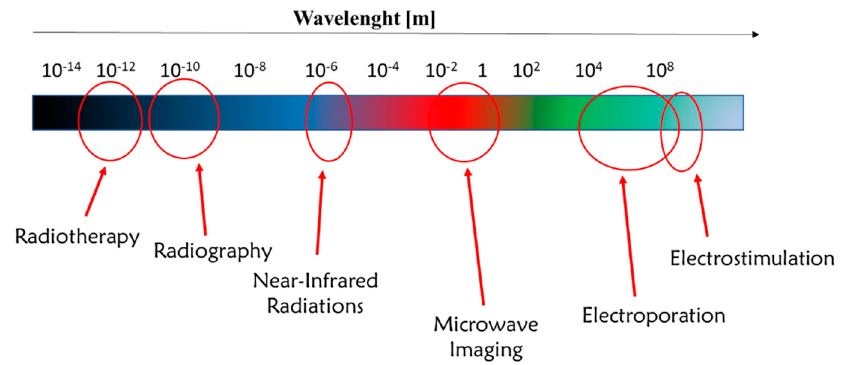
Figure 4. Applications of electromagnetic radiations in medicine.